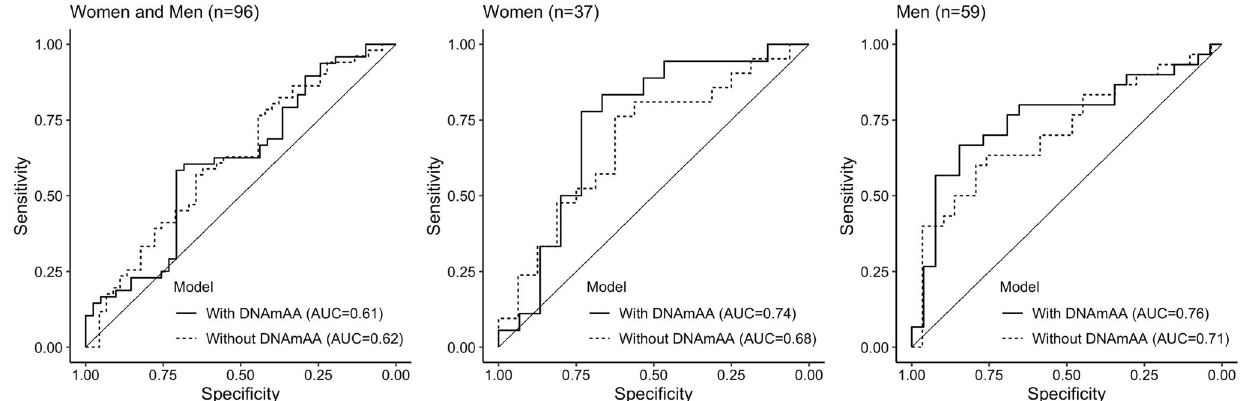
Fig. 3 Prediction of T2D complications as assessed with the DCSI. The basic model used for complication prediction includes chronological age (years), sex (if applicable), alcohol intake (g/d), packyears (years), antidiabetic medication (yes/no), and BMI. The differences between ROC curves of the model with and without 7-CpG DNAmAA were statistically not signi fi cant ( p > 0.05). Note: DNAmAA = DNA methylation age acceleration, AUC = Area Under